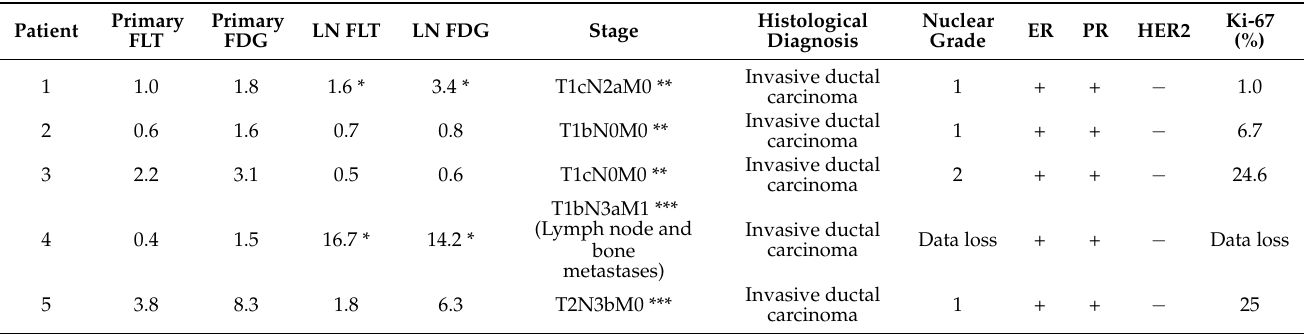
Table 2. Positron emission tomography/computed tomography (PET/CT) and pathology results of treatment-naive patients before